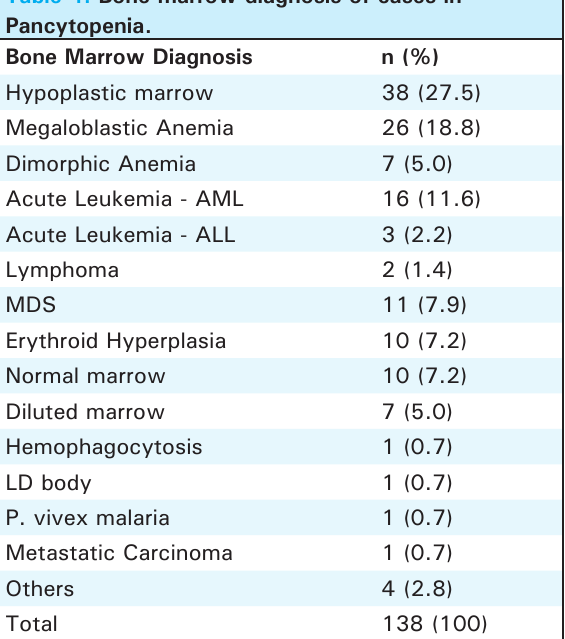
Table 4. Bone marrow diagnosis of cases in